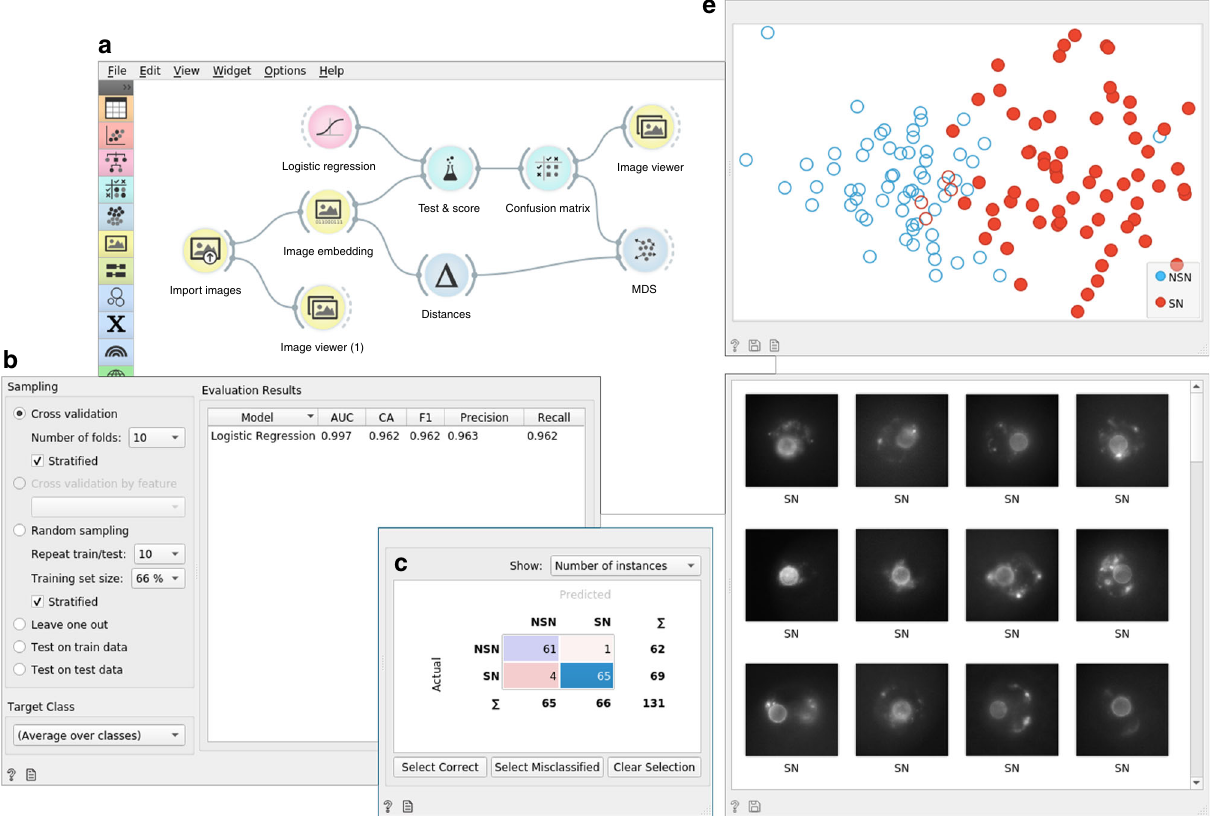
Fig. 3 Supervised data analysis of 131 mouse oocyte images with surrounded (SN) or not surrounded (NSN) chromatin organization. a The data analysis work fl ow fi rst imports the data from the local directory where images are stored in respective subdirectories named SN and NSN. Vector-based embedding passes the data matrix to a cross-validation widget (Test and Score) that accepts a machine-learning method (logistic regression) as an additional input. The Test and Score widget displays the cross-validated accuracy (area under ROC curve — AUC, classi fi cation accuracy — CA, and harmonic average of the precision and recall — F1 score) ( b ) and sends the evaluation results to the Confusion Matrix widget ( c ). The Confusion Matrix widget provides information on misclassi fi cation. In this example, 65 of the 69 SN oocytes were classi fi ed correctly. Selection of this particular cell in the Confusion Matrix triggers sending these images and their descriptors further down the work fl ow to an Image Viewer ( d ) and, as a subset of data points, to the MDS widget that performs multi-dimensional scaling ( e ). Just like in Fig. 1, the MDS widget shows a planar projection of data points (images) and highlights, in this case, the image points selected in the Confusion Matrix. Altogether, the components of this work fl ow are used to quantitatively evaluate the expected performance of machine-learning models through cross-validation and to support further exploration of correctly and incorrectly classi fi ed